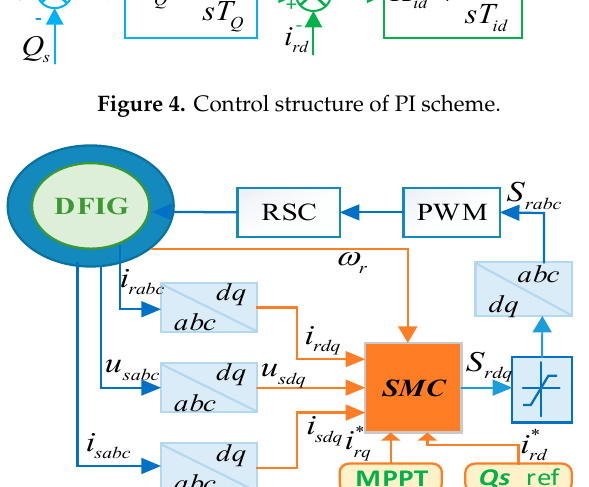
Figure 5. Conventional first ‐ order sliding mode control (SMC) scheme.